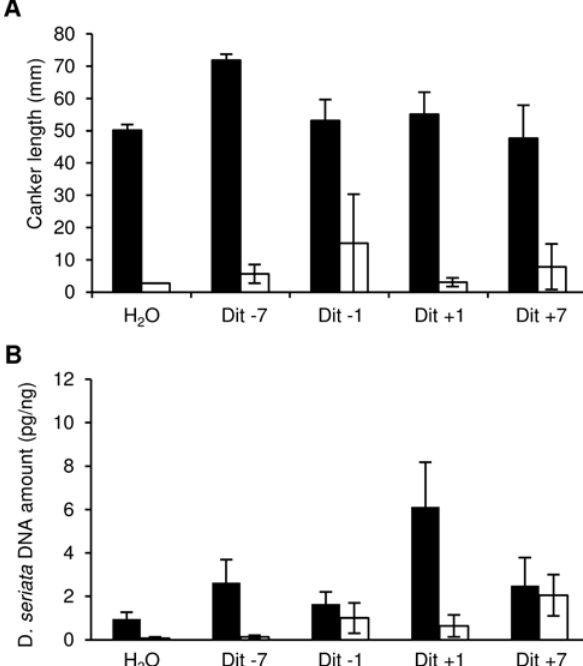
Figure 5. Diplodia seriata S a) mycelium growth and b) conidium viability after incubation in water (H 2 O) or in presence of the fun- gicides: captan (Cap), dithianon (Dit), fluazinam (Flu), ziram (Zir) or penconazole (Pen). Mycelia and conidia were incubated for 5 h with the different treatments and then plated onto potato dex- trose agar. Mycelium growth and conidium viability were assessed, respectively, as the colony diameter and colony forming units per unit of volume (CFU mL -1 ) 3 and 2 d after incubation at 27°C. The Kruskal-Wallis test showed no significant differences between the two experimental repetitions ( P > 0.05, n = 6 replicates per experi- ment) and data from the two experiments were pooled. Means and standard errors for 12 replicates (dishes) from the two experiments are shown for each treatment. Different letters indicate significant differences (Kruskal-Wallis test; P ≤